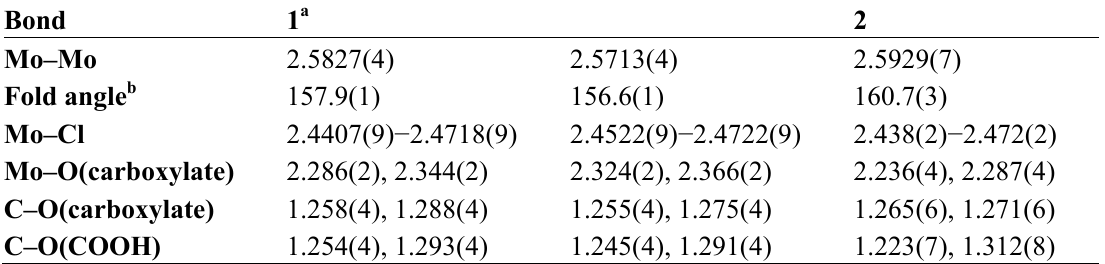
O Cl ( μ -dmsH)] 3 − ions in 1 and 2 . 2 4 4 2